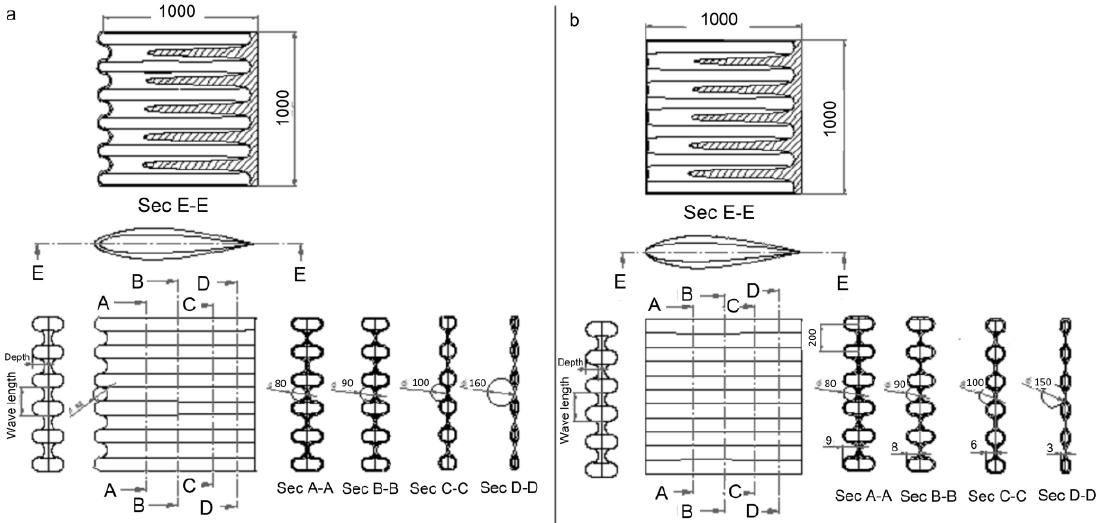
Figure 3. The detail design and the main dimensions of the circular corrugated profile. ( a ) Linear, ( b ) circular corrugated edge.